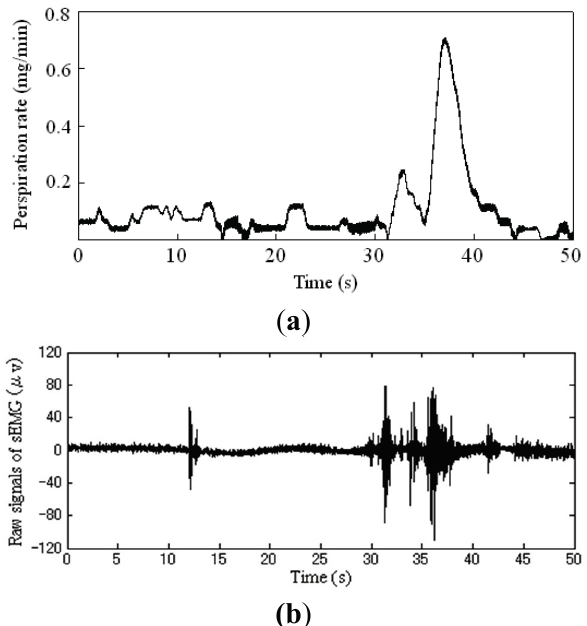
Figure 7. Examples of the measured biosignals in the automatic driving with a 4 m gap distance. ( a ) Raw signal of palmar perspiration rate; ( b ) Raw EMG signal of